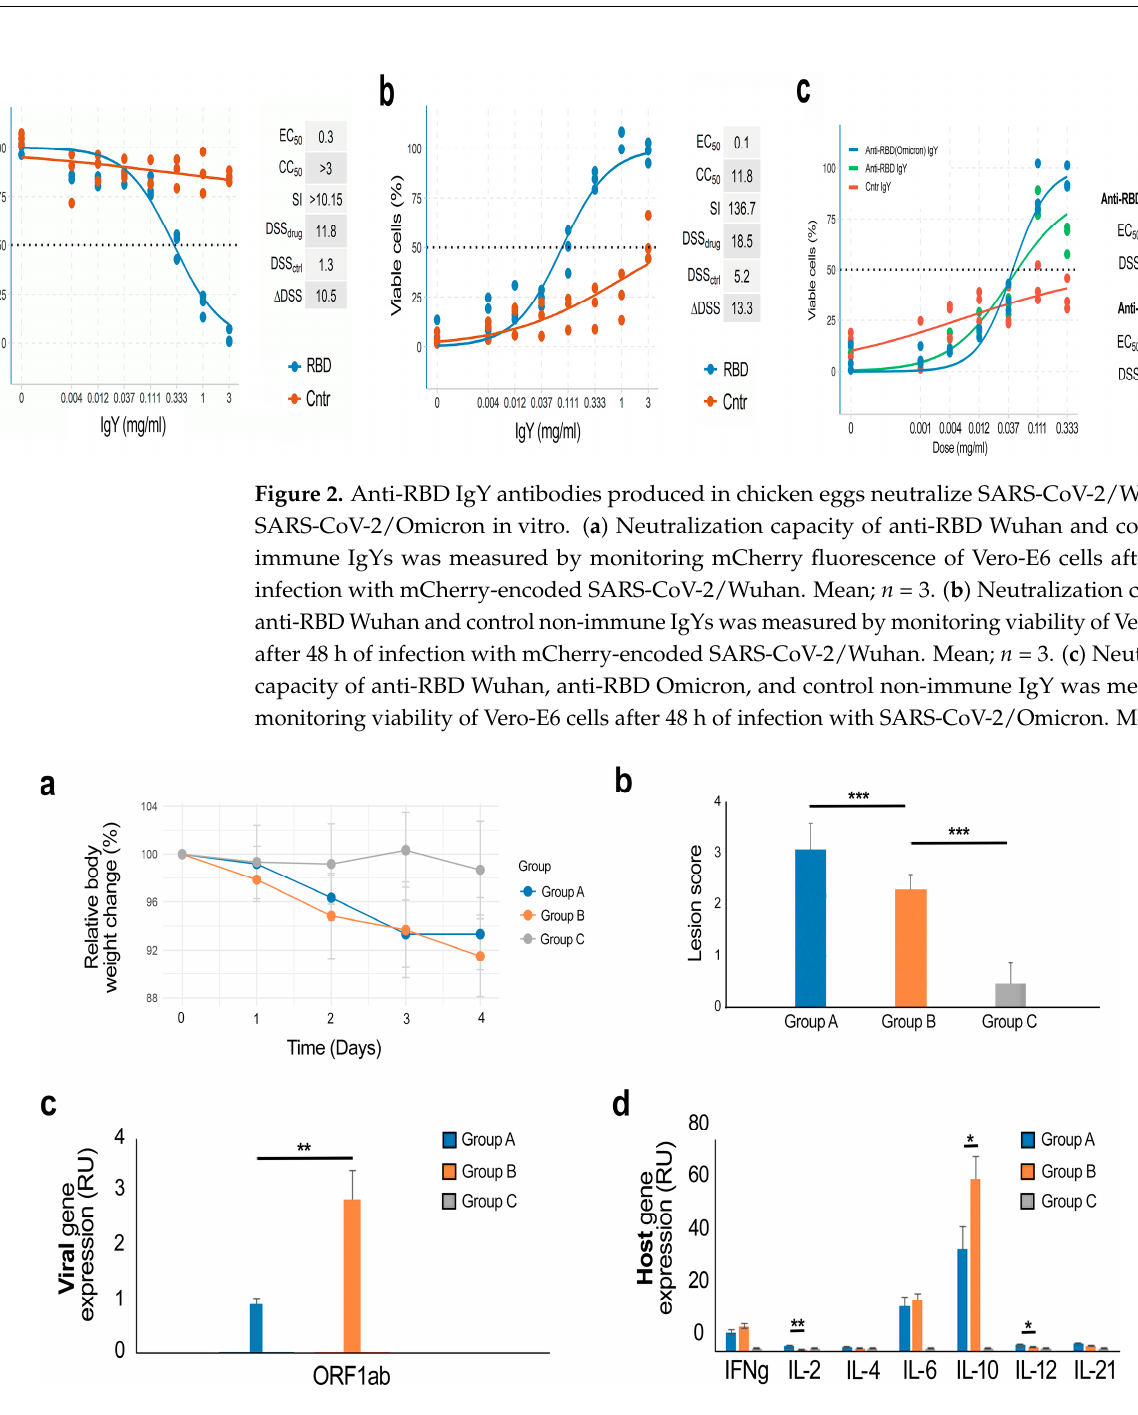
Figure 3. IgY antibodies produced in chicken eggs against RBD of S protein of SARS-CoV-2/Wuhan reduce viral RNA amplification, with minimal alteration of virus-mediated immune gene expression in lungs of infected Syrian Golden hamsters. ( a ) Body weight changes expressed in % in relation to D0 of group A (IgY-treated, virus-infected), group B (virus-infected), and group C (mock-infected) animals ( n = 6/group). ( b ) Lesion scores in the lungs of Syrian Golden hamsters. Statistical evaluation was performed using Wilcoxon rank-sum test (***— p < 0.001). Mean ± SD; n = 6. ( c ) Effect of anti-RBD_S_SARS-CoV-2/Wuhan IgYs on the expression of SARS-CoV-2 gene in lungs of Syrian Golden hamsters. Mean ± SD; n = 6. *— p < 0.1, **— p < 0.05 (Wilcoxon test). ( d ) Effect of anti-RBD IgYs on the expression of host cytokine genes in lungs of Syrian Golden hamsters. Mean ± SD; n = 6. *— p < 0.1, **— p < 0.05 (Wilcoxon test).